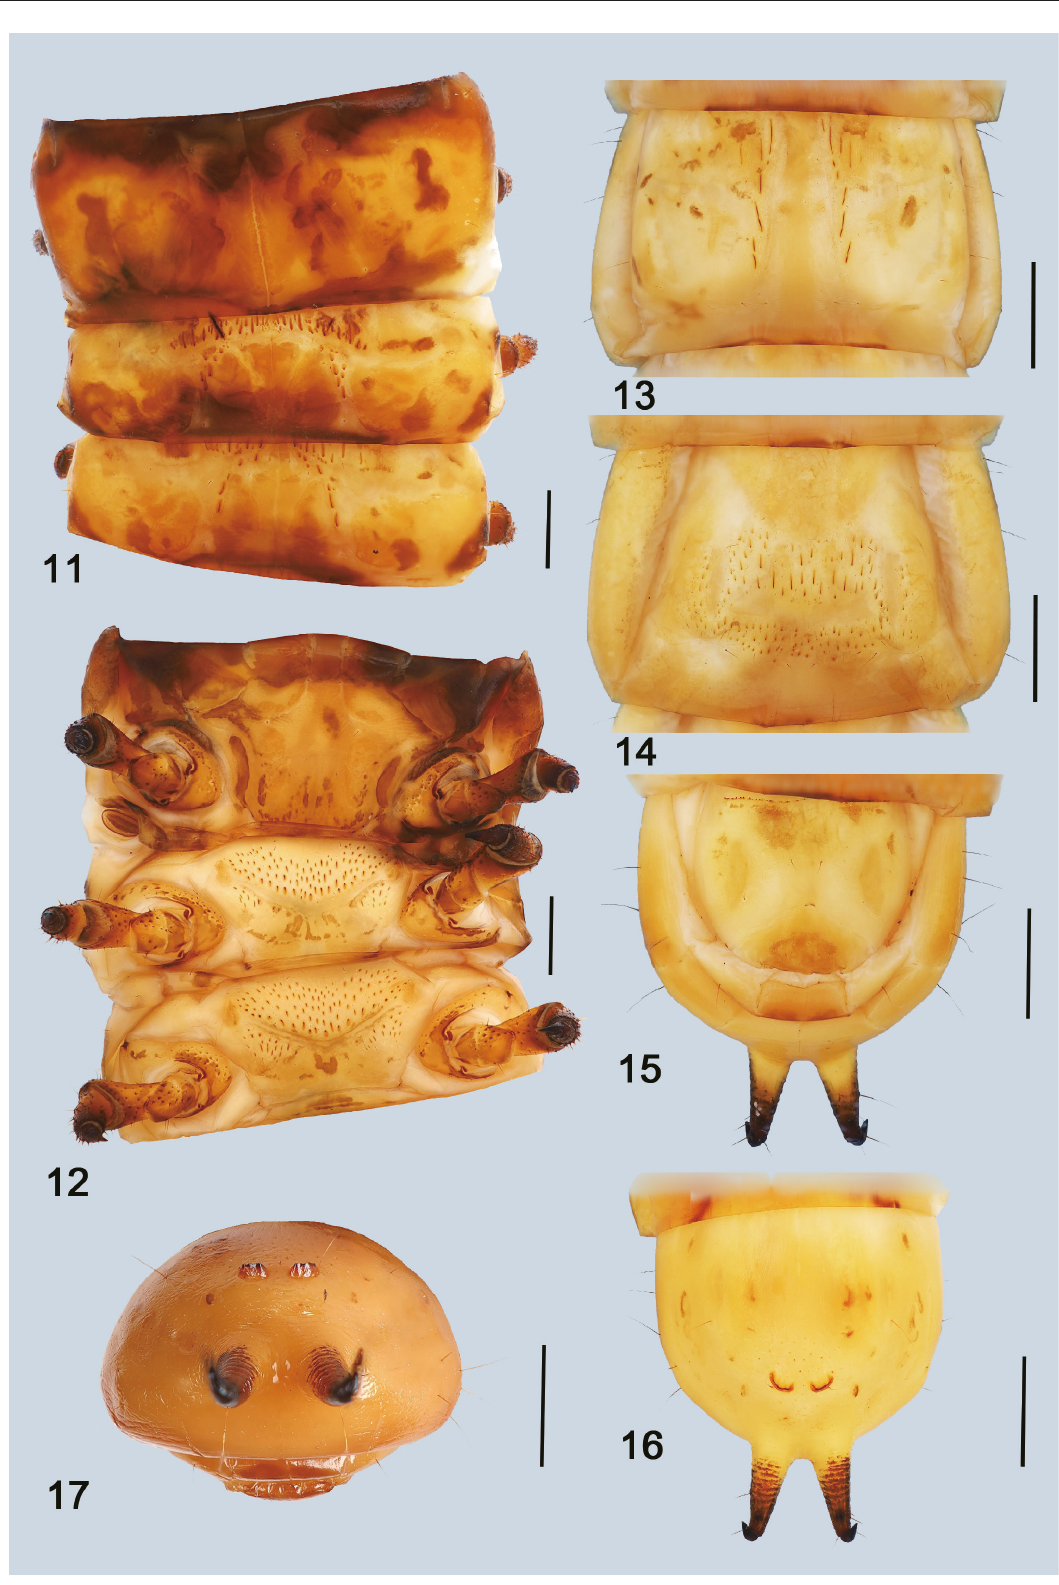
Figs 11–17. Thorax and abdominal segments 5 and 9 of last-instar larva of Trictenotoma formosana Kriesche, 1919. 11–12 . Thorax (11 = dorsal view, 12 = ventral view). 13 . Tergite 5. 14 . Sternite 5. 15 . Sternite 9. 16 . Tergite 9. 17 . Abdominal segment 9, posterior view. Scale bars: